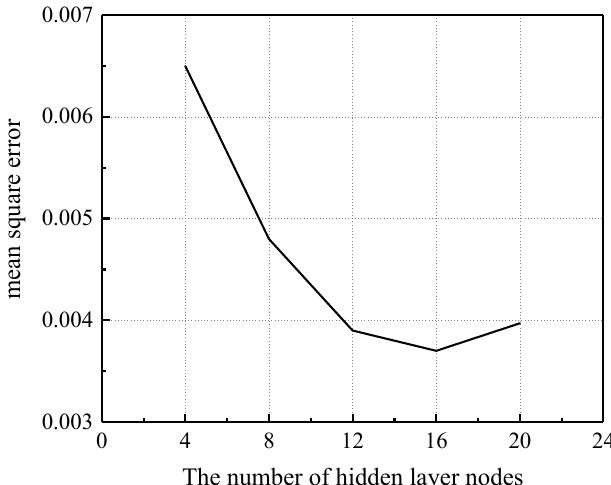
Figure 6. The influence of the number of hidden layer nodes on the network.